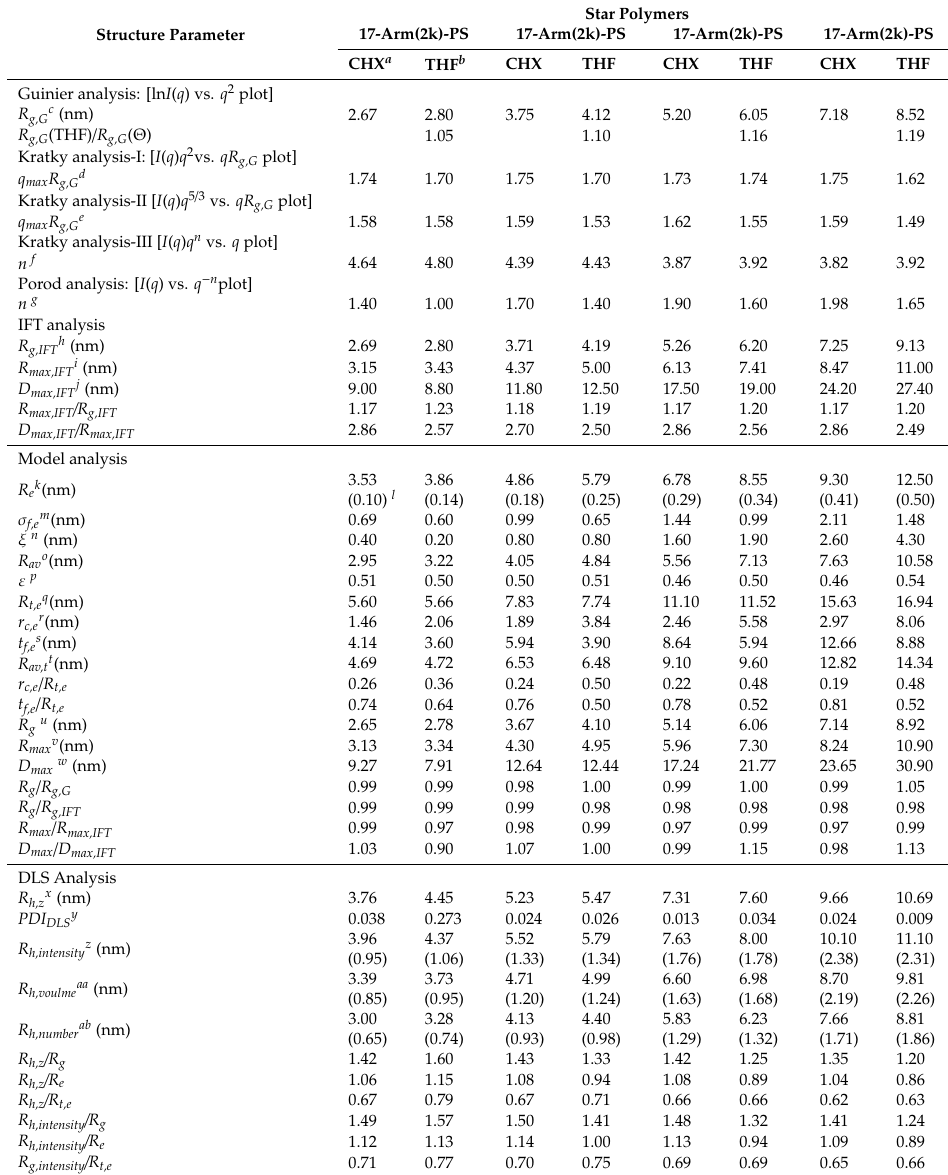
Table 2. Structural parameters of 17-armed star polystyrenes obtained by X-ray scattering and dynamic light scattering (DLS)